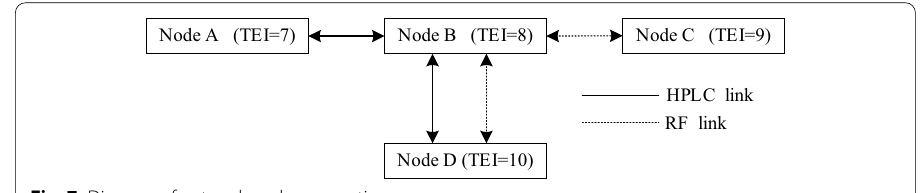
Fig. 7 Diagram of network node connection